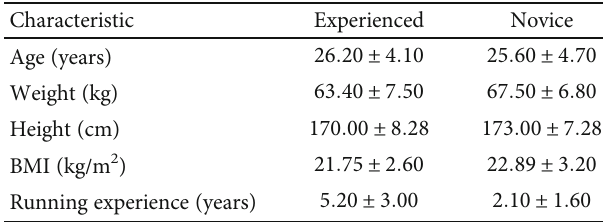
Table 1: The basic demographics of subjects ( n = 24 ). Characteristic Experienced